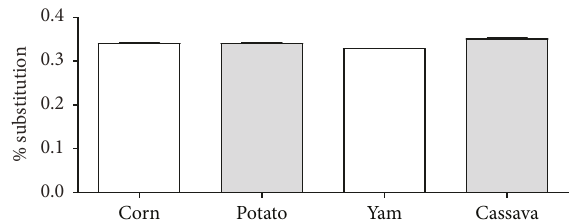
Figure 2: Graphical representation of the substitution percentages of the lipophilized